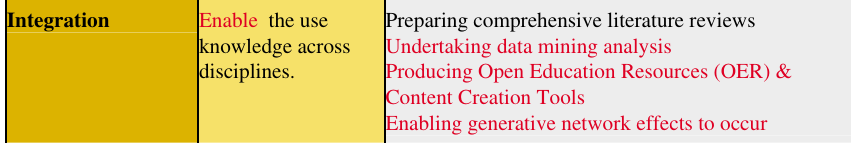
Figure 2. Integration ‘type’ of Boyer’s Model of Scholarship (modified).